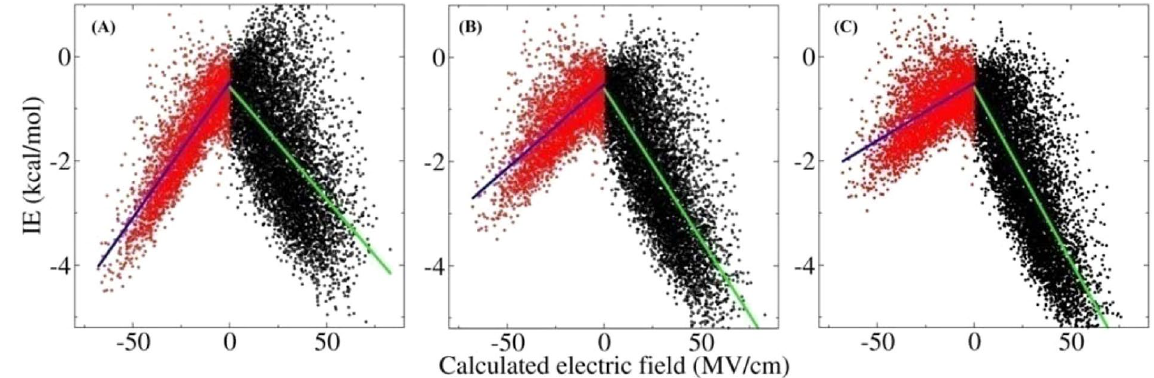
Figure 7. Distribution of the calculated interaction energies between the QM (CO molecule) and the MM (the surroundings) subsystems at the ( A ) HF/aug-cc-pVTZ/Amberff99SB, ( B ) B3LYP/aug-cc-pVTZ/Amberff99SB, and ( C ) MP2/aug-cc-pVTZ/Amberff99SB QM/MM levels as a function of the electric fields along the CO bond. The interaction energies exhibit a linear relationship with the electric fields. The green and blue lines represent the regression curves of the interaction energies relative to the positive and negative electric fields.